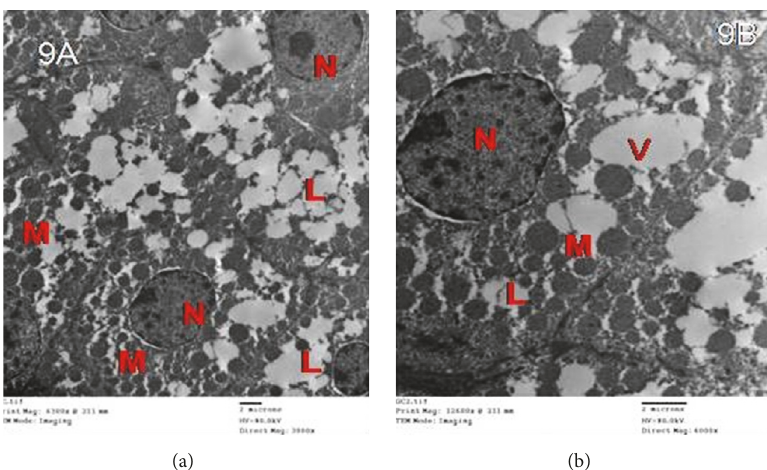
Figure 9: Electron micrographs of the adrenal cortex in group III showing that ZG cells with (a) euchromatic nuclei (N) have irregular outlines, an apparent increase in lipid droplets (L), and mitochondria with intact cristae (M). (b) showings cytoplasmic vacuoles (V) and a euchromatic nucleus with peripheral clumps of heterochromatin (N). Note: numerous lipid droplets and mitochondria (M) more or less as the control.